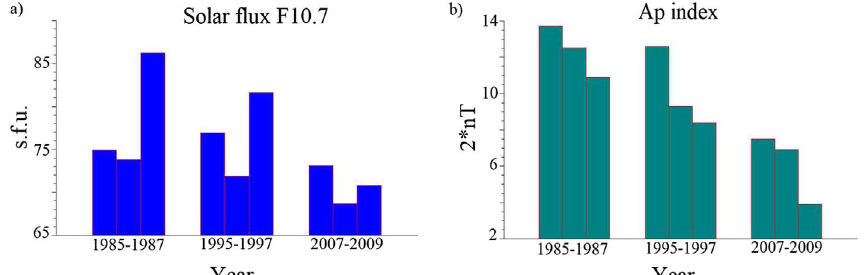
Fig. 2. In panel (a) is reported the yearly average value of the solar fl ux F10.7, for the considered years of minimum of cycles 21, 22 and 23. Panel (b) shows yearly average value of a p index, for the